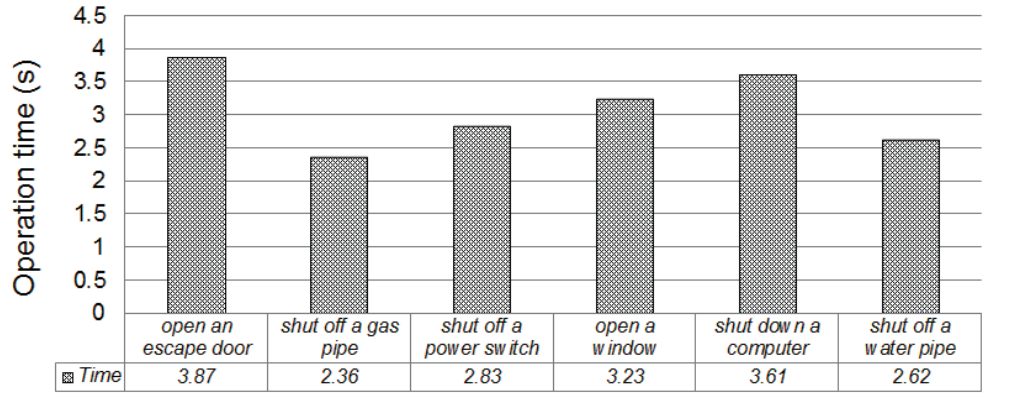
Figure 13. The operation time of each task.